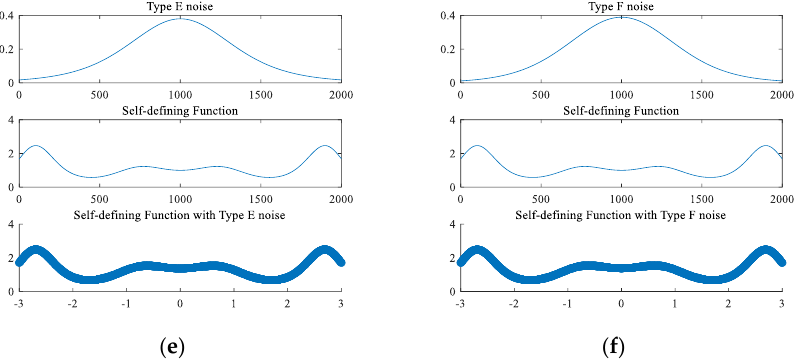
Figure 3. Graphs of the self-defining function with different noises.